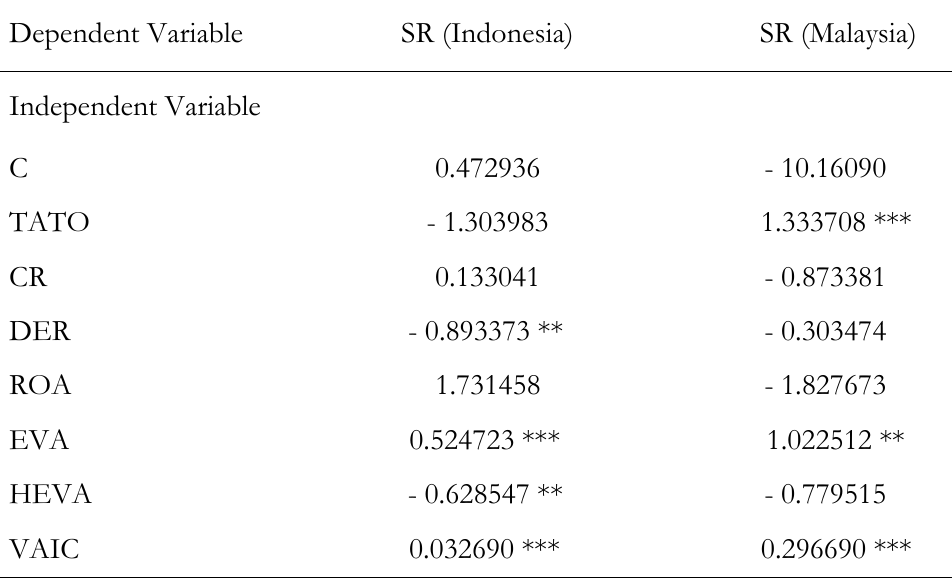
Regression Results of Energy Company Data in Indonesia and Malaysia Dependent